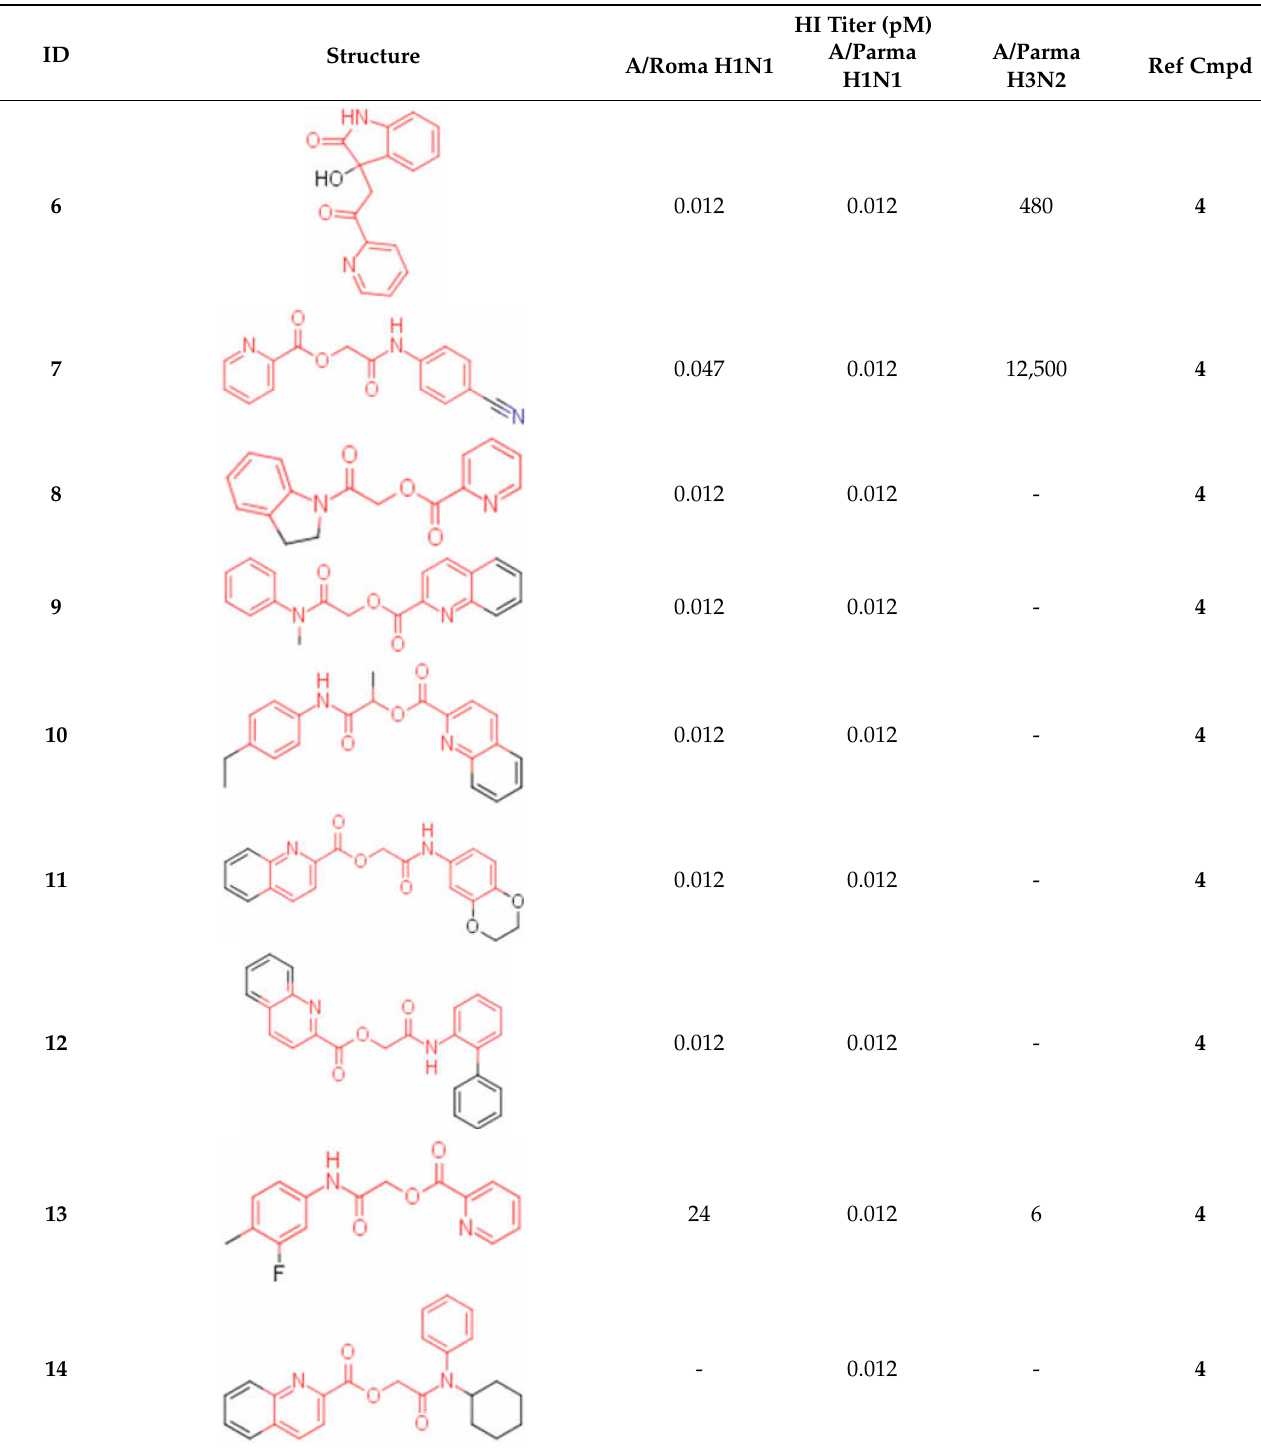
Table 2. HI titers of the 23 active compounds toward at least one of the HA strains. Common substructure is highlighted in blue for ligand 1 analogues and in red for ligand 4